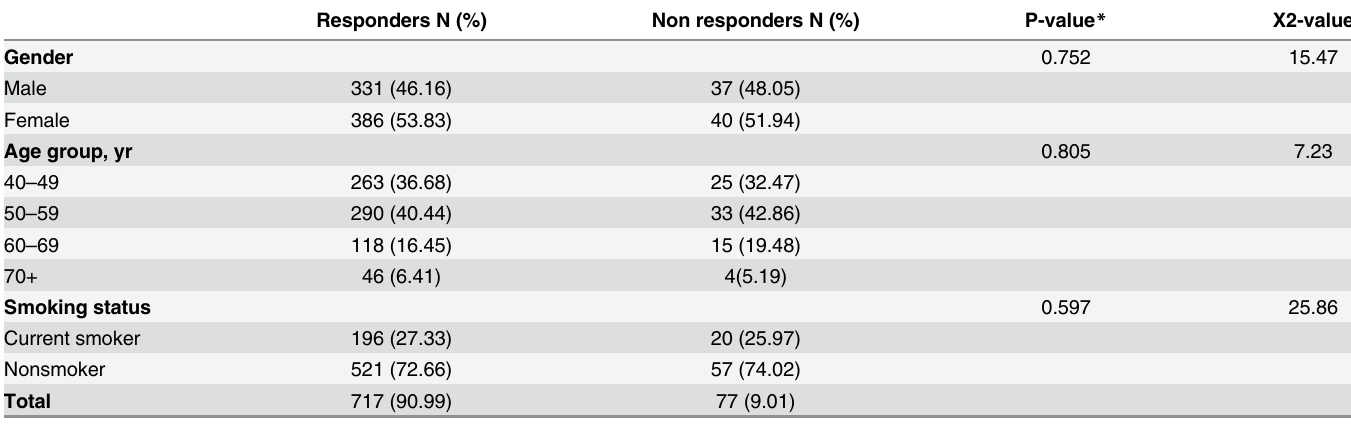
Table 1. Comparison of responders and non-responders.